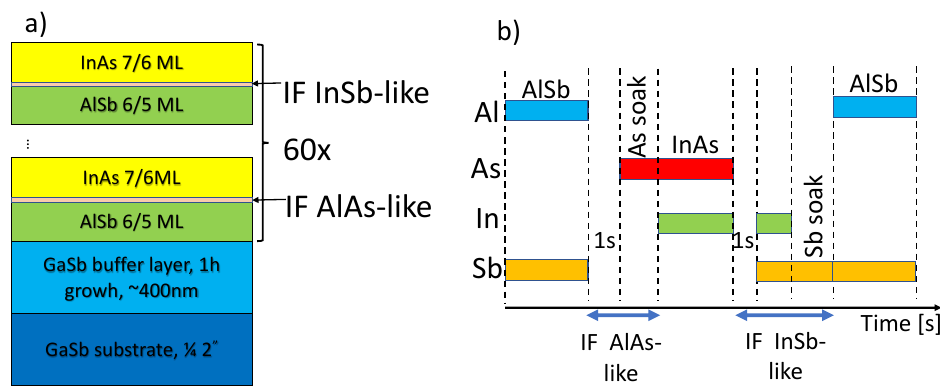
Figure 1. ( a ) The architecture of the InAs/AlSb structures. ( b ) The shutters sequences for the MBE growth of investigated InAs/AlSb